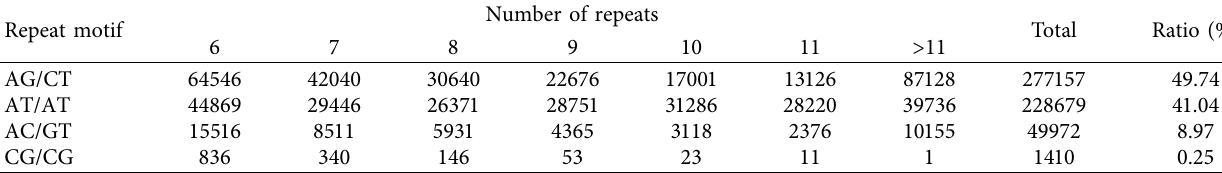
Table 5: Statistics of dinucleotide 557, 218 motifs.